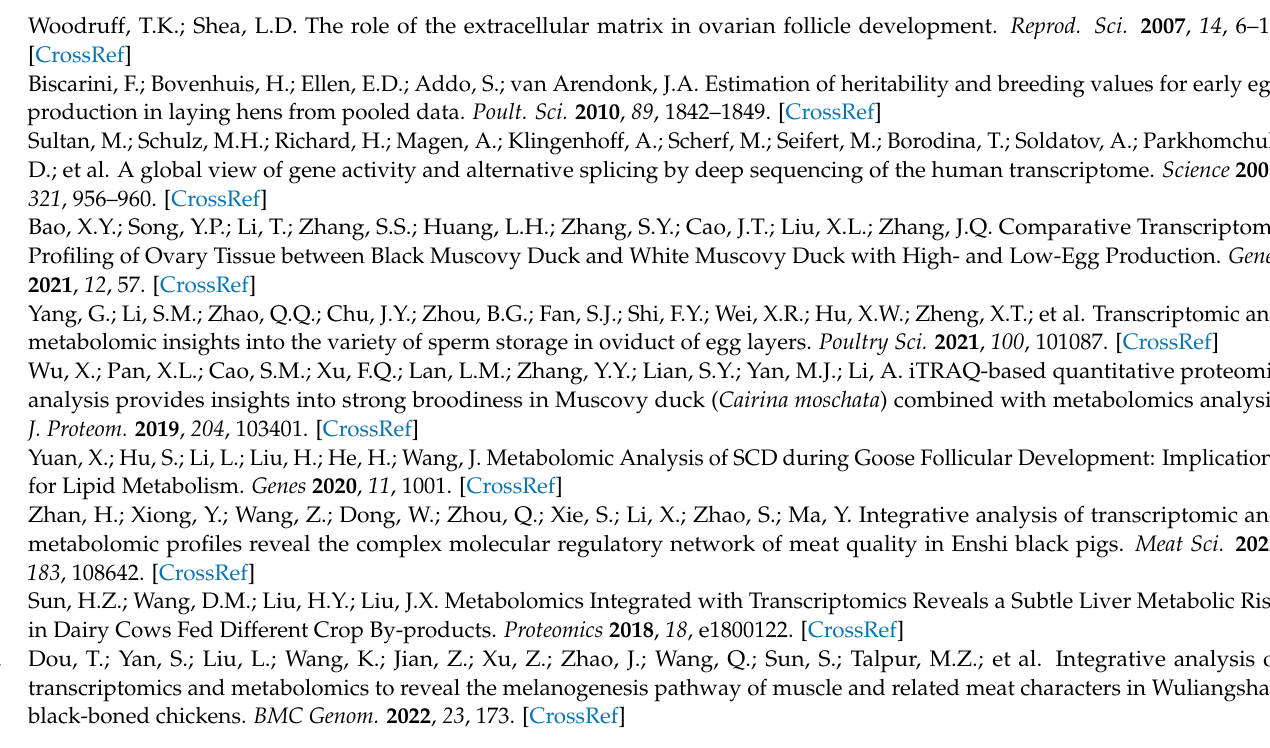
Table S2: KEGG enrichment analysis of SDMs; Table S3: Significantly differential expression genes; Table S4: All KEGG pathways of DEGs; Table S5: Correlation of DEGs and SDMs; Table S6: The common KEGG pathways of Transcriptomics and